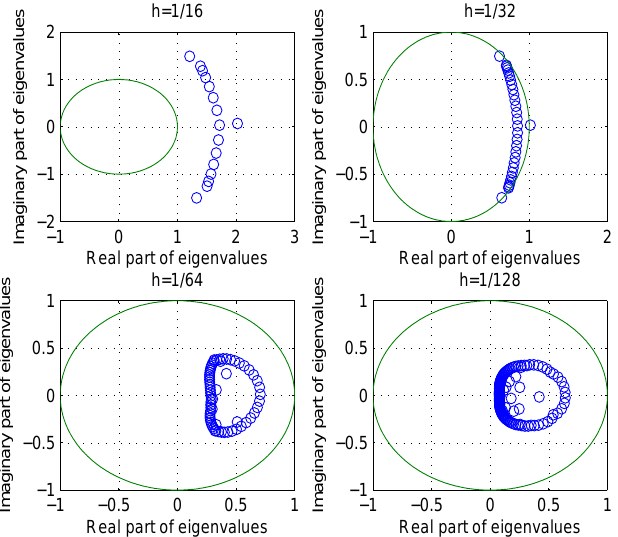
Figure 1. The spectrum of h A ( 1 : N ,2 : N + 1 ) for various stepsizes h